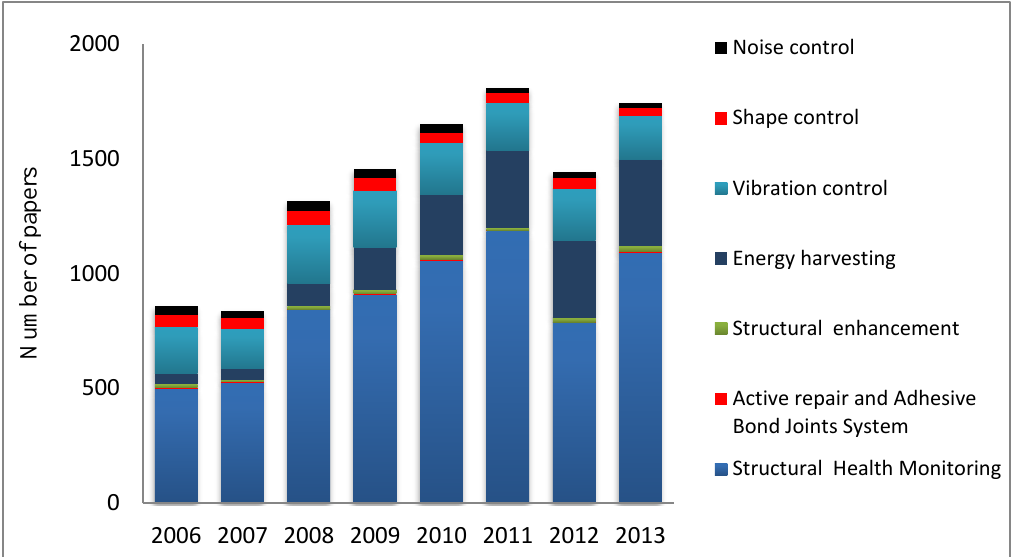
Figure 2. Research